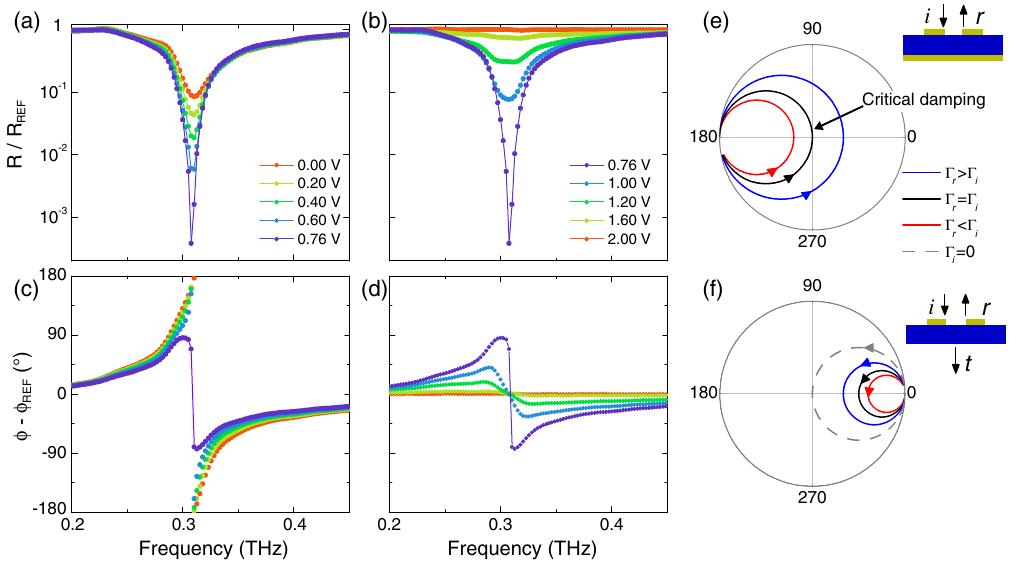
FIG. 2. Gate-controlled reflection modulation and the proposed resonator model based on CMT. The variation of reflectance ¼ 0 . 76 V (see text). The reflectances for Δ V . A critical transition occurs at Δ V ( R ¼ j r j 2 ) with the relative gate voltage Δ V g c ≥ Δ V and Δ V are shown in (a) and (b), respectively. The spectra are measured for a device with an 85 - μ m-thick SU8 spacer. The g c lateral dimensions of the Al mesas are 100 μ m × 160 μ m, and the mesa array has periods of 240 μ m in the x and y directions, ¼ 2 . 02 V is used as the reference. (c),(d) Phase modulations for Δ V respectively. The spectrum measured at Δ V g Δ V ≥ Δ V , respectively. Data are obtained for the same device used for measurements in (a) and (b). (e) Smith curves of the reflection g c coefficient r for the one-port model illustrated in the inset. The blue, black, and red curves represent underdamping, critical damping, and overdamping behavior, respectively. (f) Smith curves of the transmission coefficient t for the two-port resonator model (inset). ¼ 0 (broken line). No critical transition is present, even in the limiting case Γ i